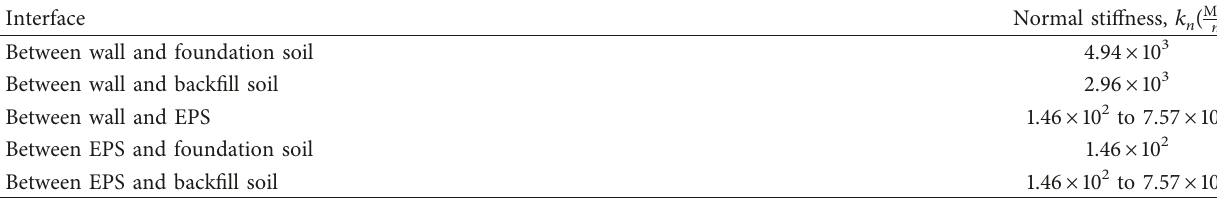
Table 6: Normal interface stiffness for the 3m and 6 m high walls.